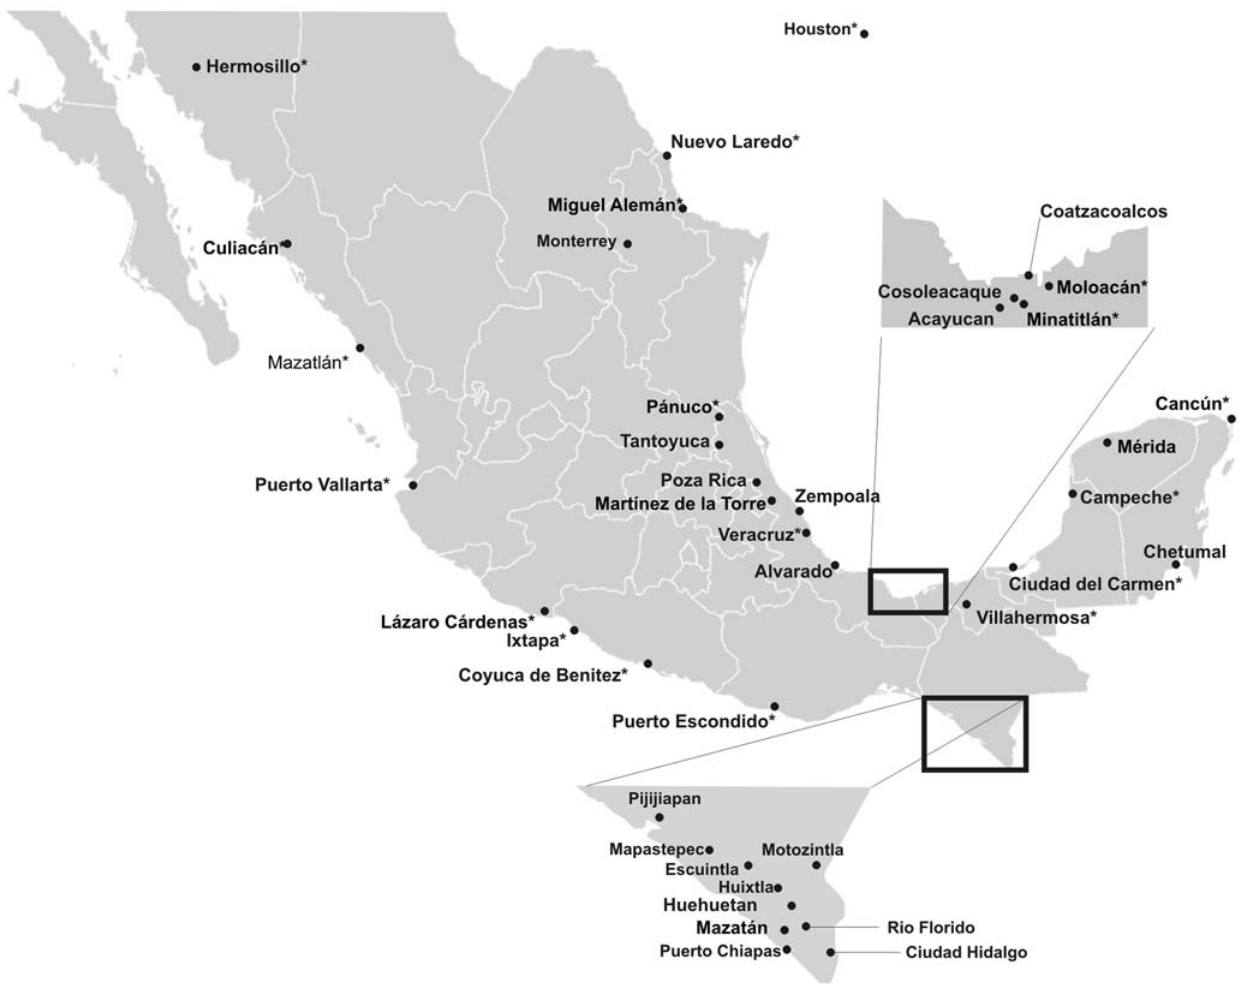
Figure 1. Locations of collection sites in Me´xico at which Ile1,016 frequencies for Aedesaegypti were estimated. Only single collections were made in those cities followed by *.